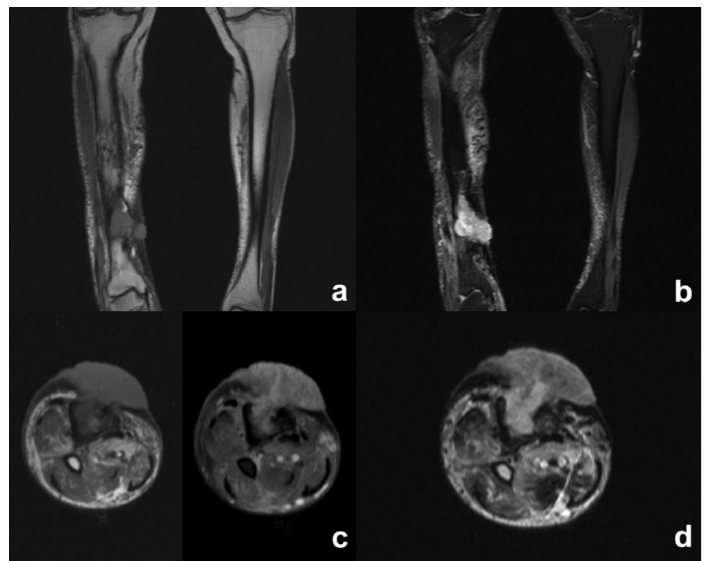
Figure 2. Squamous cell carcinoma of the right leg. ( a ) Cor T1-w shows deformity of the tibial diaphysis with abnormal marrow signal intensity and cortical destruction on the anterior aspect of the distal third of the tibia. There is a large mass developing in soft peridiaphyseal tissue. ( b ) Cor STIR shows intermediate-to-high signal of the mass and mild edema of the subcutaneous tissue of the right leg. ( c ) Tra T1-w pre- and post-medium administration shows a large fungating mass developing from medullary canal beyond the subcutaneous tissue and skin, and post-gadolinium enhancement of the endocanalar tissue. ( d ) Tra T2-w displays an intermediate intensity signal of the tumoral tissue.